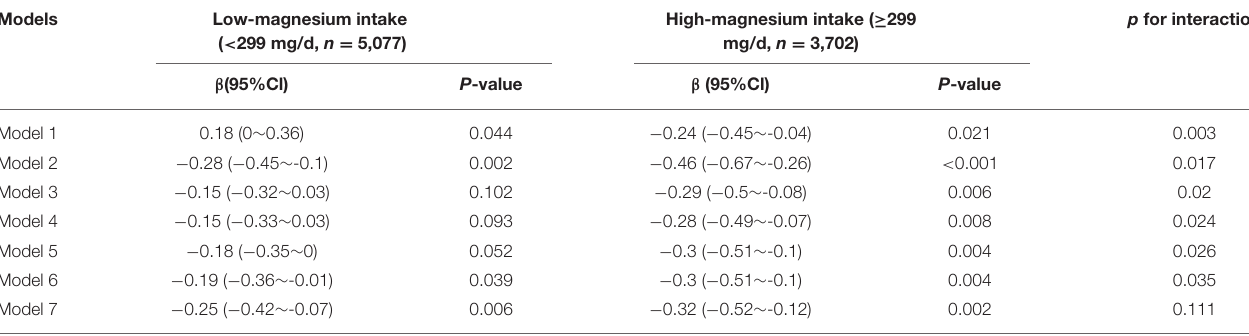
TABLE 3 | Interactive effect of vitamin D and dietary magnesium intake on systolic blood pressure (SBP). Models Low-magnesium intake ( < 299 mg/d, n = 5,077)